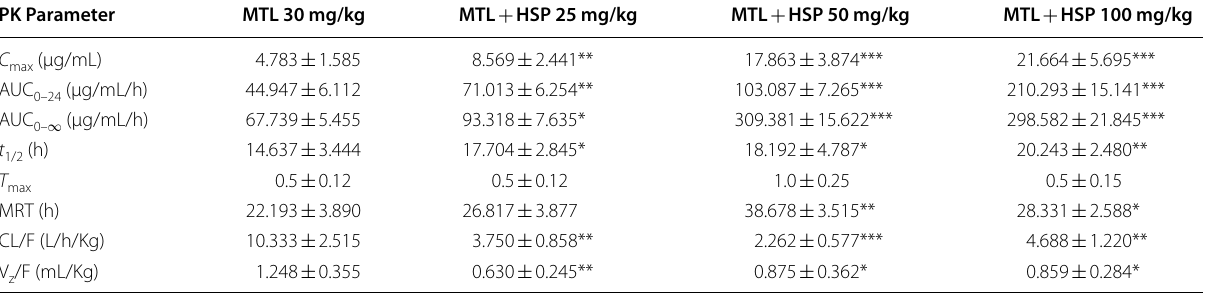
Table 2 Pharmacokinetic parameters of metoprolol succinate in the presence or absence of hesperetin (25, 50, and 100 mg/kg) on the 15th day (n 6) =